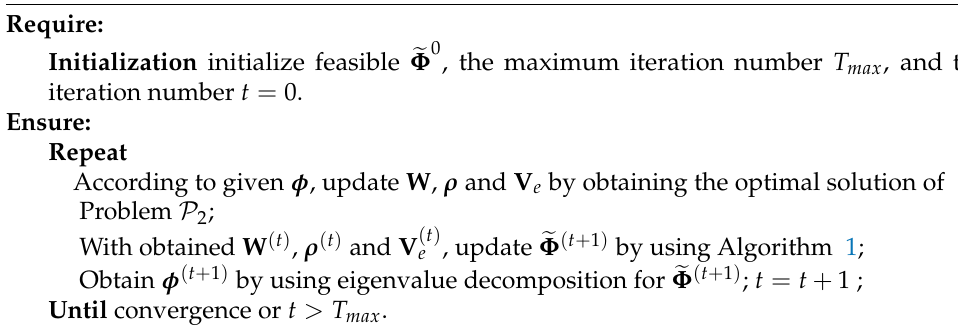
Algorithm 2 Alternating algorithm for minimizing transmit power consumption of